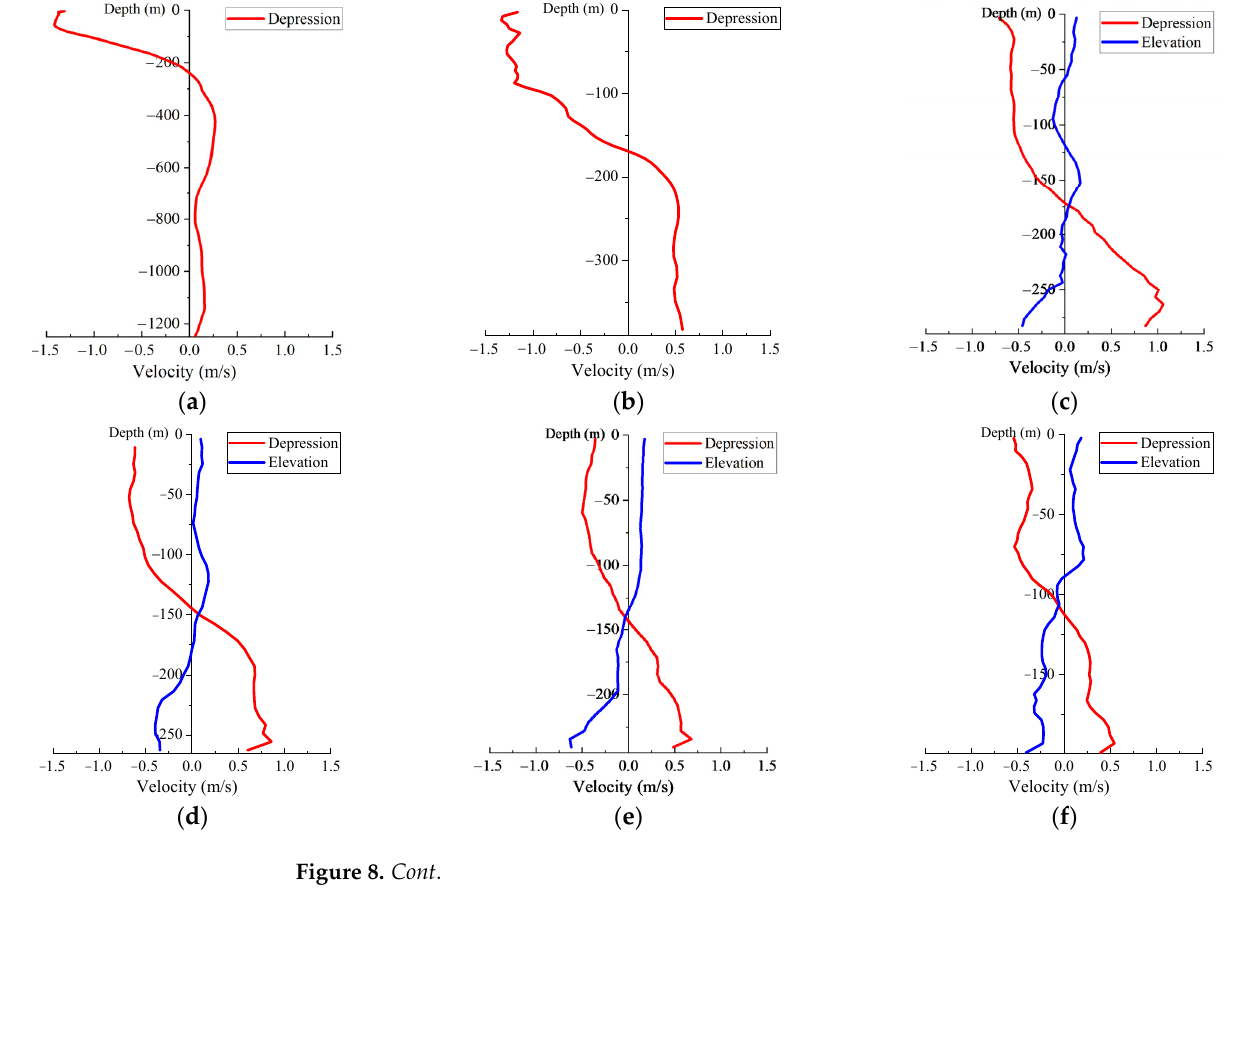
Figure 7. The isotherm of internal waves propagating on the continental slope along cross-section